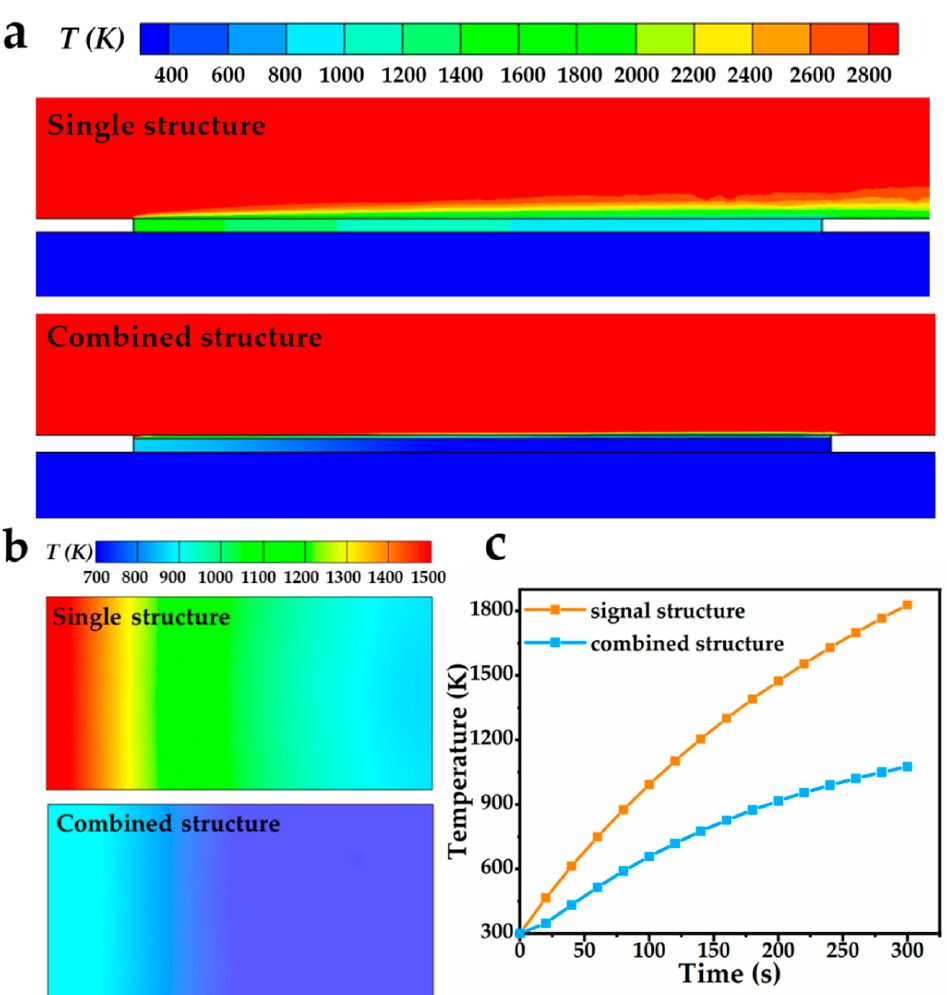
Figure 6. ( a ) Temperature distribution on the lengthwise section at the centerline of two structures; ( b ) temperature distribution on the surface of the plates; ( c ) temperature variation of the plate sur- faces.